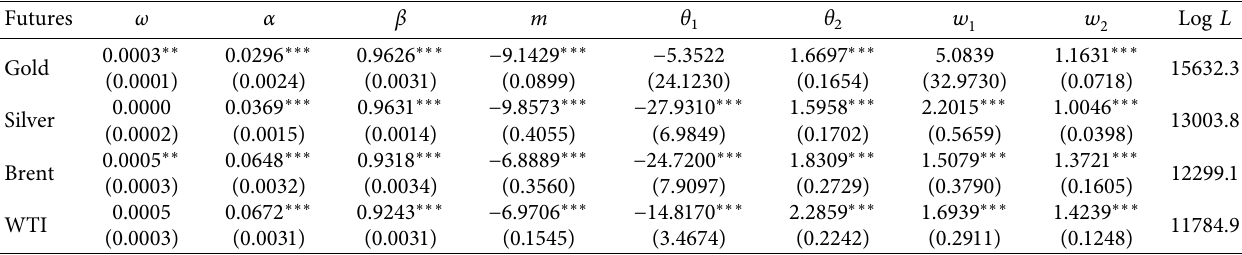
Table 7: Estimation results of GARCH-MIDAS +RV +ID-EMV models of futures volatility by infectious disease with 6-month lags. Futures